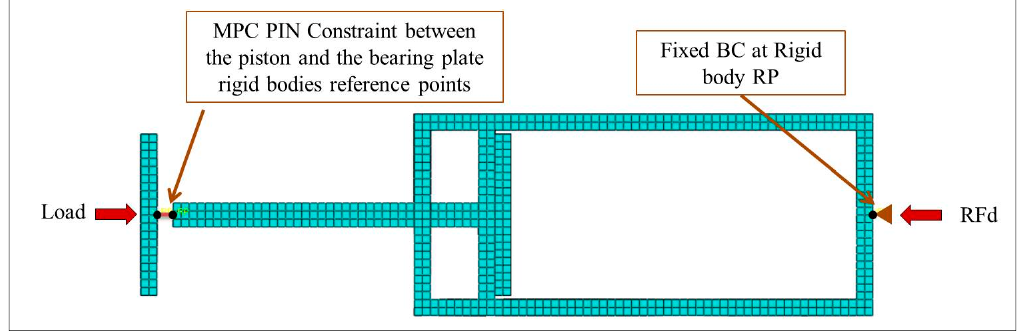
Figure 2. Boundary conditions and constraints of the bearing plate, piston and damper body.